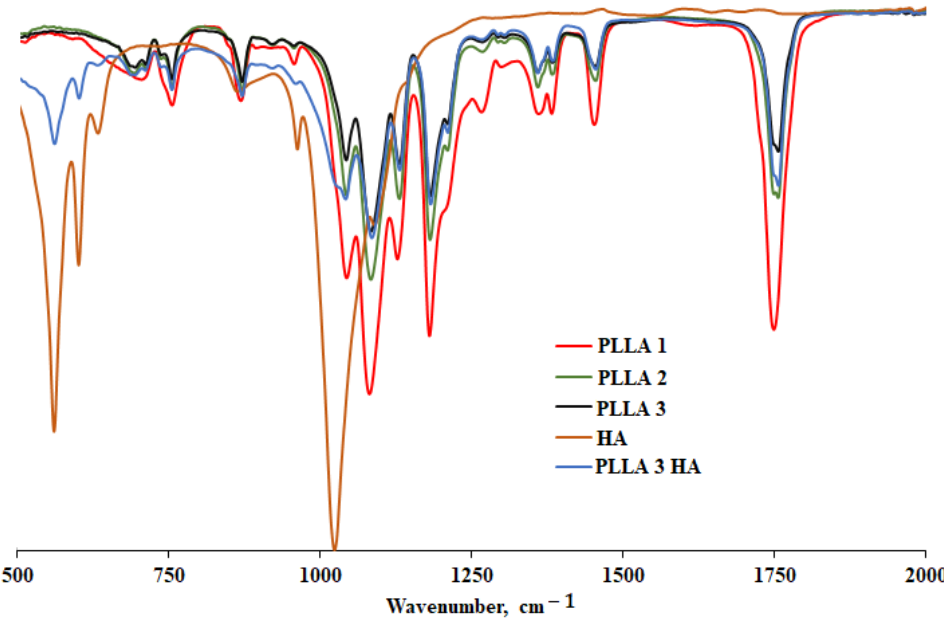
Figure 3. IR spectra of unfilled and hydroxyapatite-filled copolylactide films.